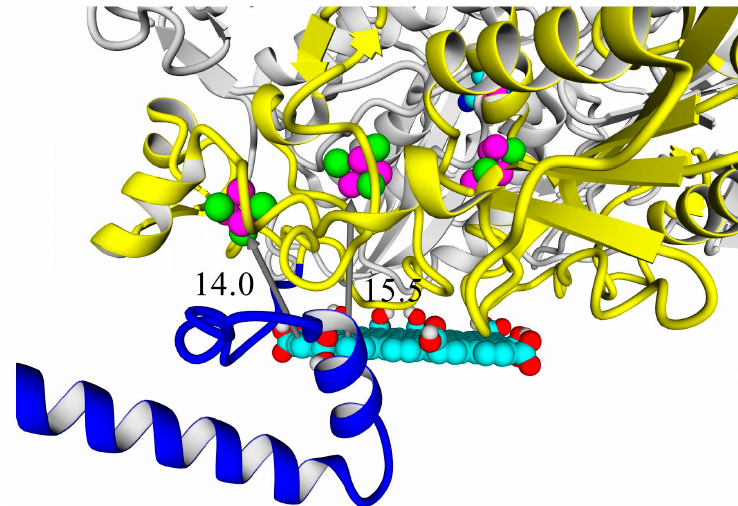
Figure 15. Docking complexes of Rba. sphaeroides HupSL hydrogenase and graphene oxide: productive complex. Distances from the aromatic plane of graphene oxide are denoted by gray arrows and labeled (14.0 Å from the plane to the nearest Fe atom in the distal FeS cluster; 15.5 Å from the plane to the medial FeS cluster). Coloring scheme: large subunit, gray; small subunit, main part, yellow; small subunit, C-end, blue; ligands and graphene oxide are colored by standard YASARA element scheme (carbon—cyan, oxygen—red, hydrogen—gray, sulfur—green, nickel and iron— magenta).